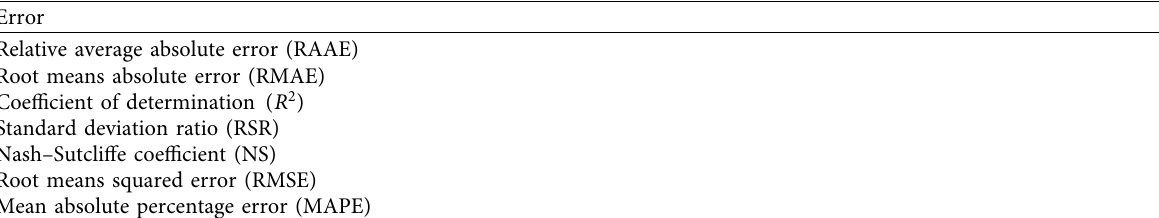
Table 9: Error analysis.